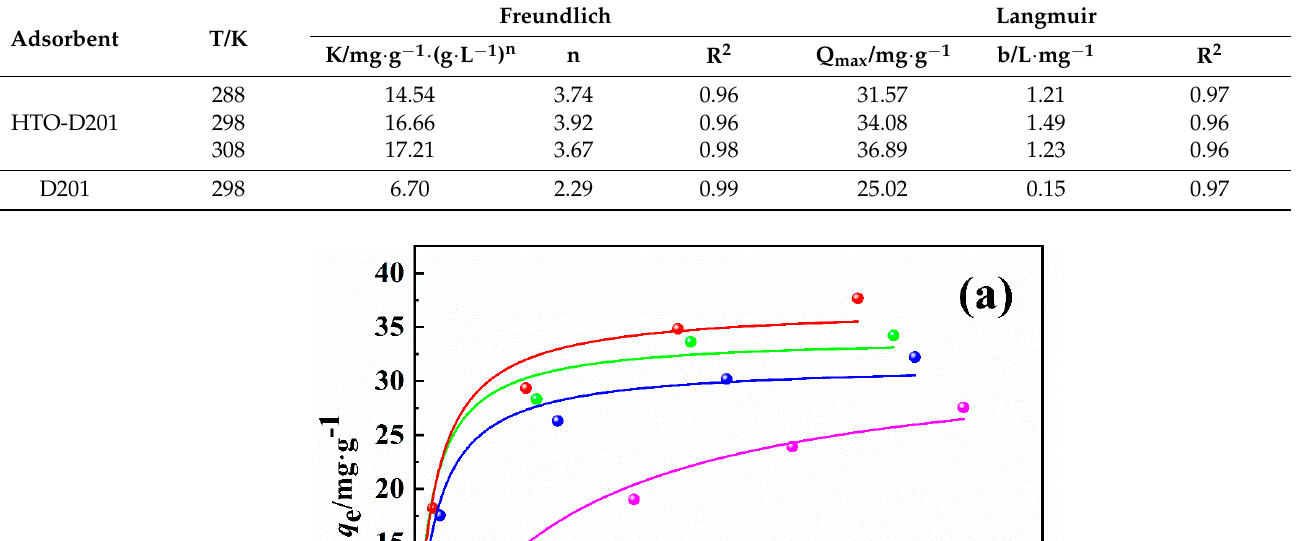
Table 2. Fitting parameters of Freundlich and Langmuir model for phosphate adsorption by HTO-D201.